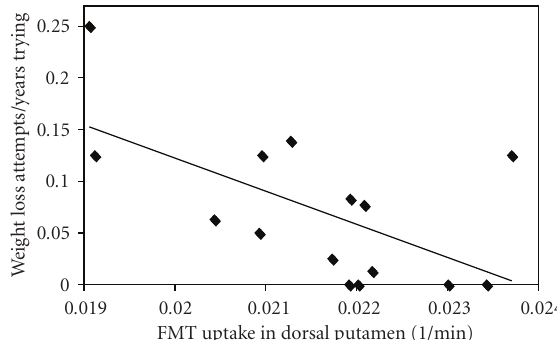
Figure 3: Relationship between Weight Loss Attempts/Years Trying and FMT uptake in the dorsal putamen averaged over the left and right hemispheres in 15 young healthy individuals. Weight Loss Attempts/Years Trying reflects an estimate of the frequency of prior weight loss attempts. FMT uptake reflects dopamine synthesis capacity and is measured as partial volume corrected influx constant, or K i in